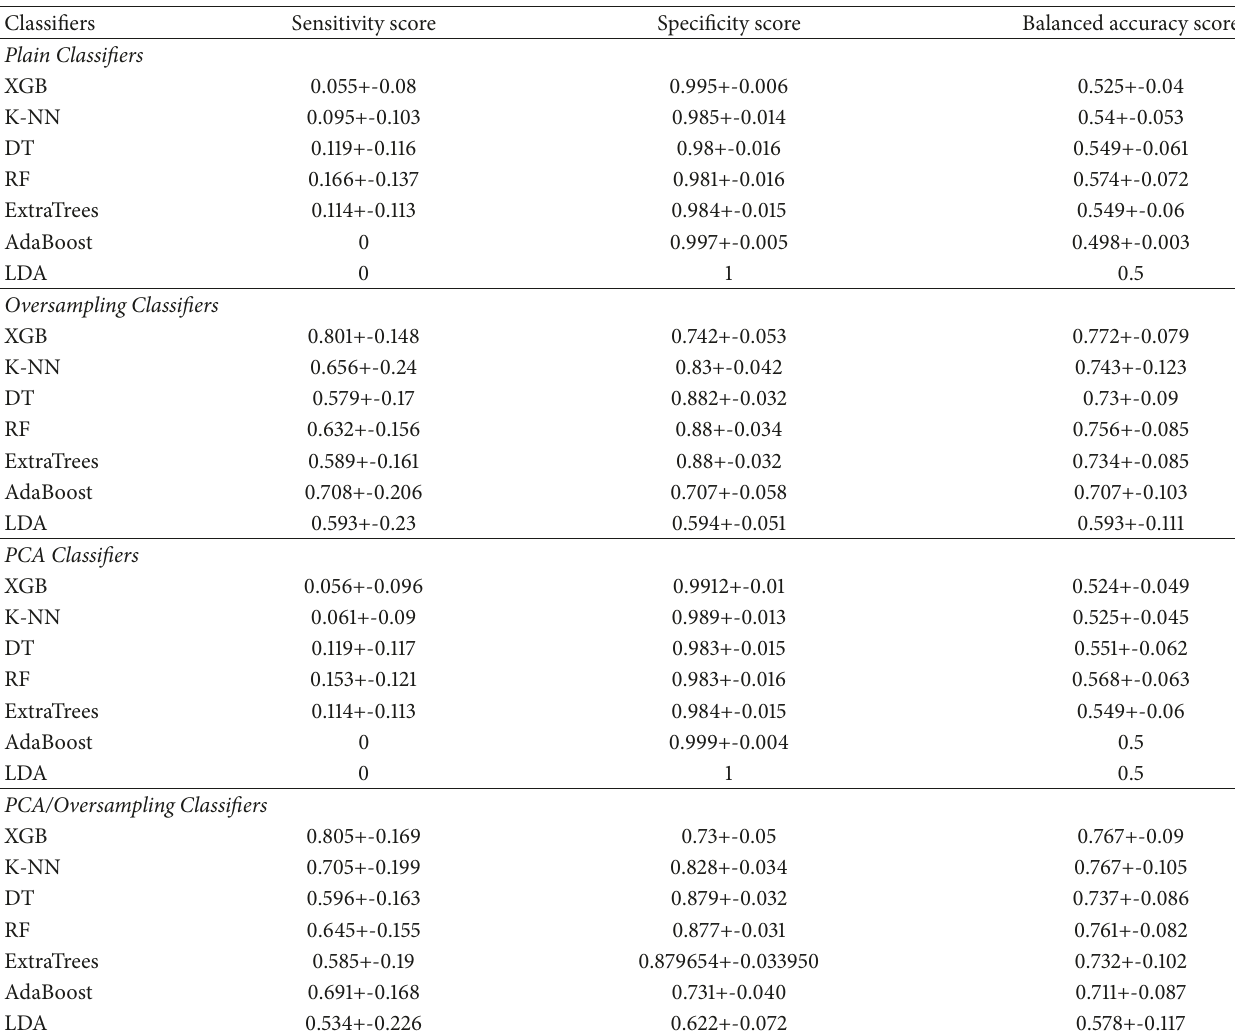
Table 5: Classifiers with a detailed range of sensitivity, specificity, and balanced